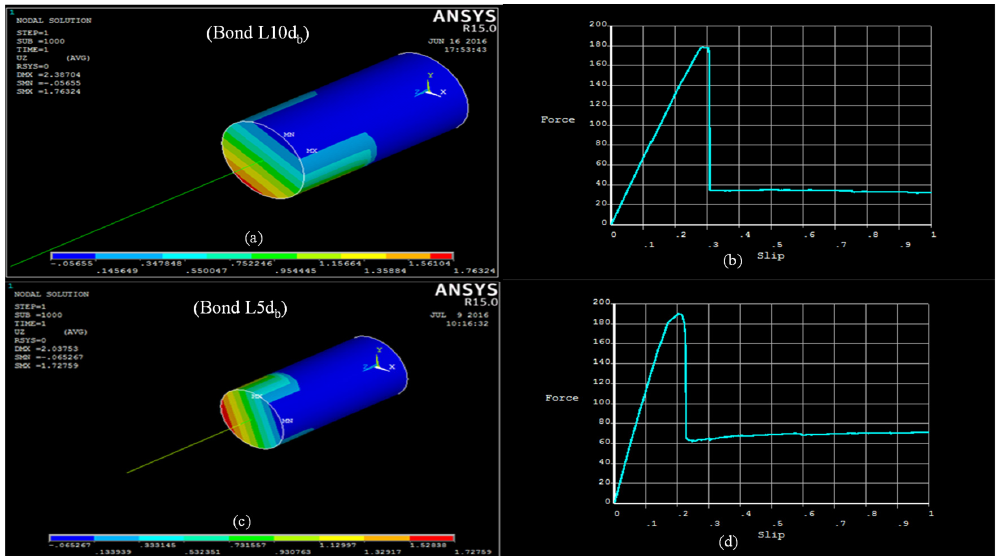
Figure 9. Stress of #16 diameter bar at failure and generated curves ( a , b ) for bond 10 d b and ( c , d ) for bond5 d b .